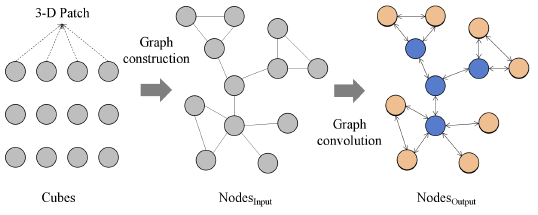
Figure 1 . Message passing in a typical